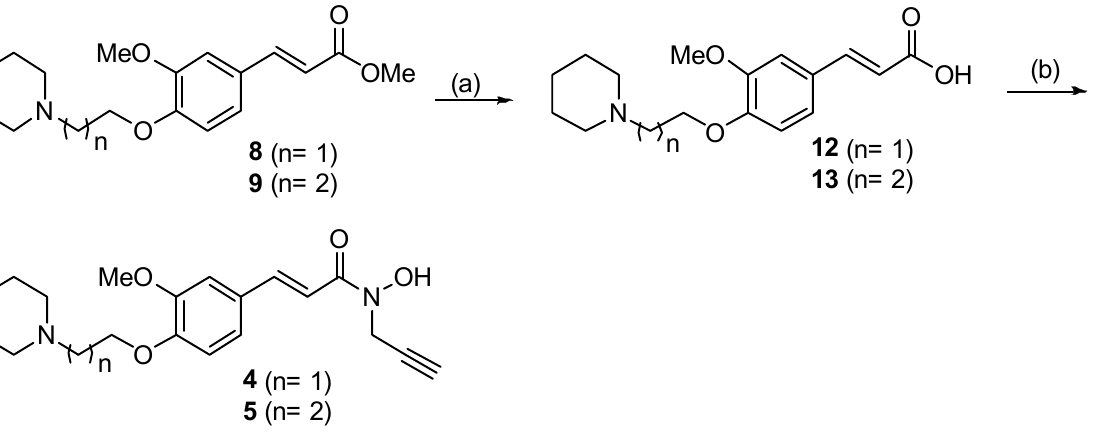
Scheme 3. Reagents and conditions: ( a ) KOH, MeOH/H 2 O ( 12 : 98%; 13 : 96%); ( b ) N -(prop-2-yn-1- yl)hydroxylamine hydrochloride, HATU, DIPEA, DMF ( 4 : 28%; 5 : 30%).